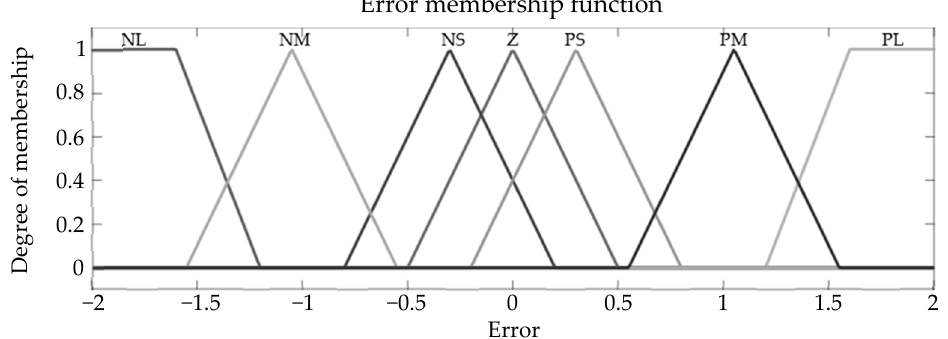
Figure 5. Error membership function .